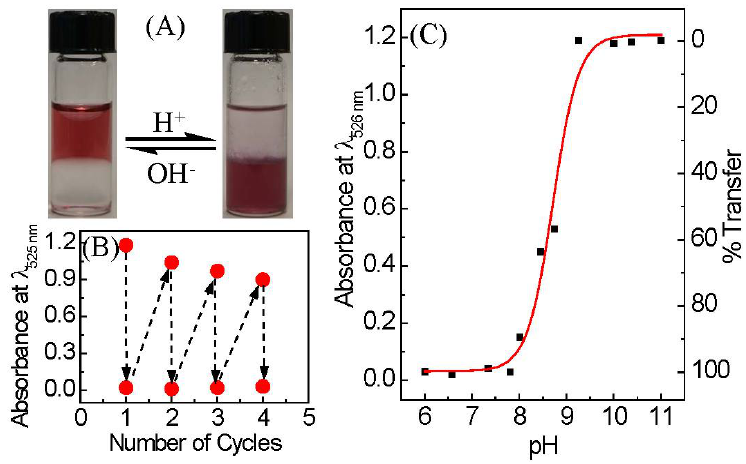
Figure 3. ( A ) Photographs of the pH-triggered reversible phase transfer of 13-nm AuNP-MUA between water and CHCl 3 layers, by switching the pH. The left side vial contains well-dispersed AuNP-MUA in the aqueous phase (top layer) at basic pH, and the right side vial contains AuNP-MUA transferred into the CHCl 3 phase (bottom) layer after adding HCl and vigorous shaking; ( B ) Plot showing pH-triggered reversible phase transfer of 13 nm AuNP-MUA between the water and organic phase, by monitoring the AuNP-MUA LSPR peak intensity at 525 nm wavelength in aqueous phase; and ( C ) absorbance of AuNP-MUA in aqueous phase at 525 nm (left scale) versus the pH and percentage transfer of AuNP-MUA from an aqueous to a CHCl 3 layer as a function of pH. The percentage of transfer was calculated by taking the absorbance of the AuNP-MUA (in aqueous medium) at pH 11.0 as 0%. The red color solid curve represents sigmoidal fitting of the experimental data.